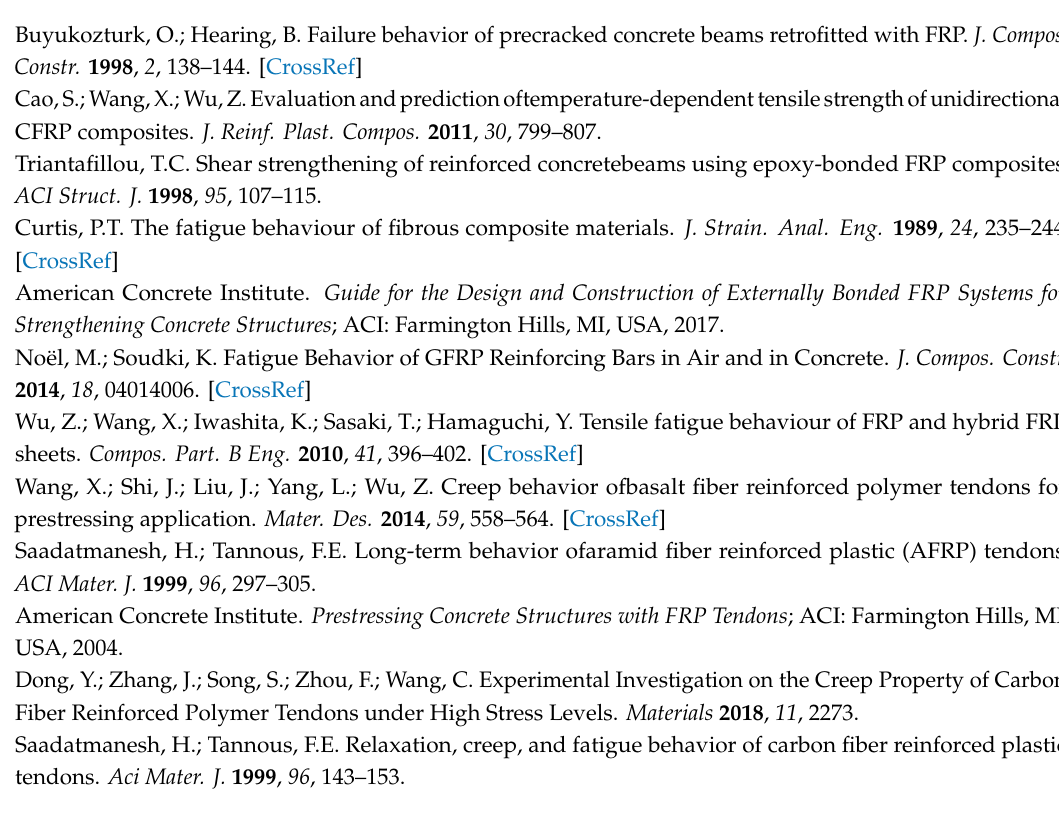
Table S1. Changing rate of fatigue life. Table S2. Comparison between calculation results of simplified Equation (3) and test results. Table S3. Comparison between calculation results of simplified Equation (4) and test